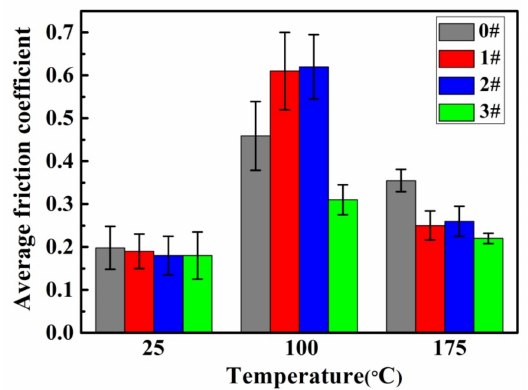
Figure 4. Average friction coefficients of different samples.